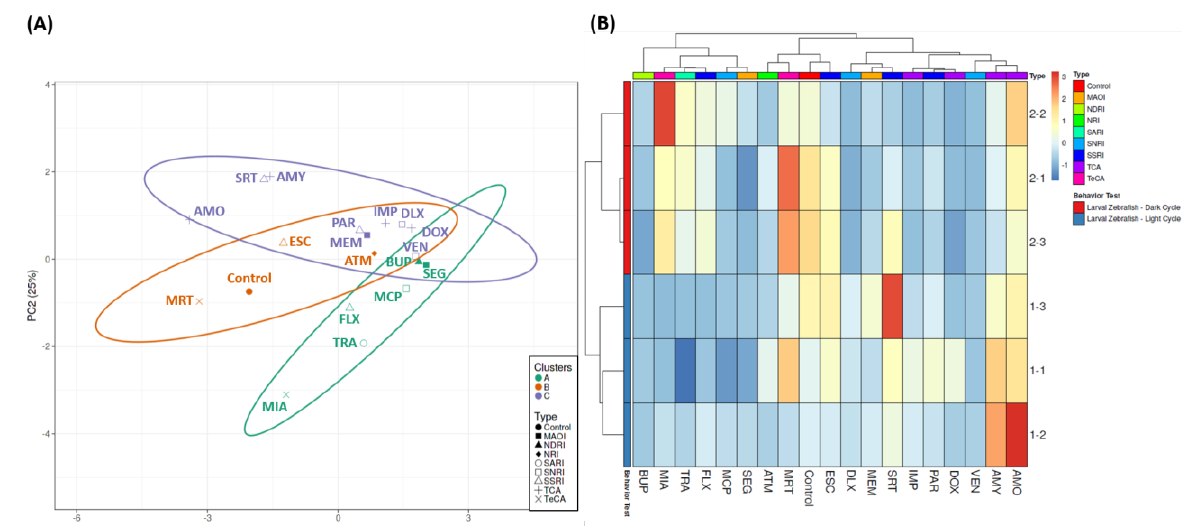
Figure 3. ( A ) Principal component analysis (PCA) and ( B ) hierarchical clustering analysis of locomotion behavior endpoints in zebrafish larvae after exposure to 1 mg/L of 18 different antidepressants. The untreated group is included as the control group. In ( A ), three major clusters from hierarchical clustering analysis results are marked with purple (1st cluster), orange (2nd cluster), and green (3rd cluster).